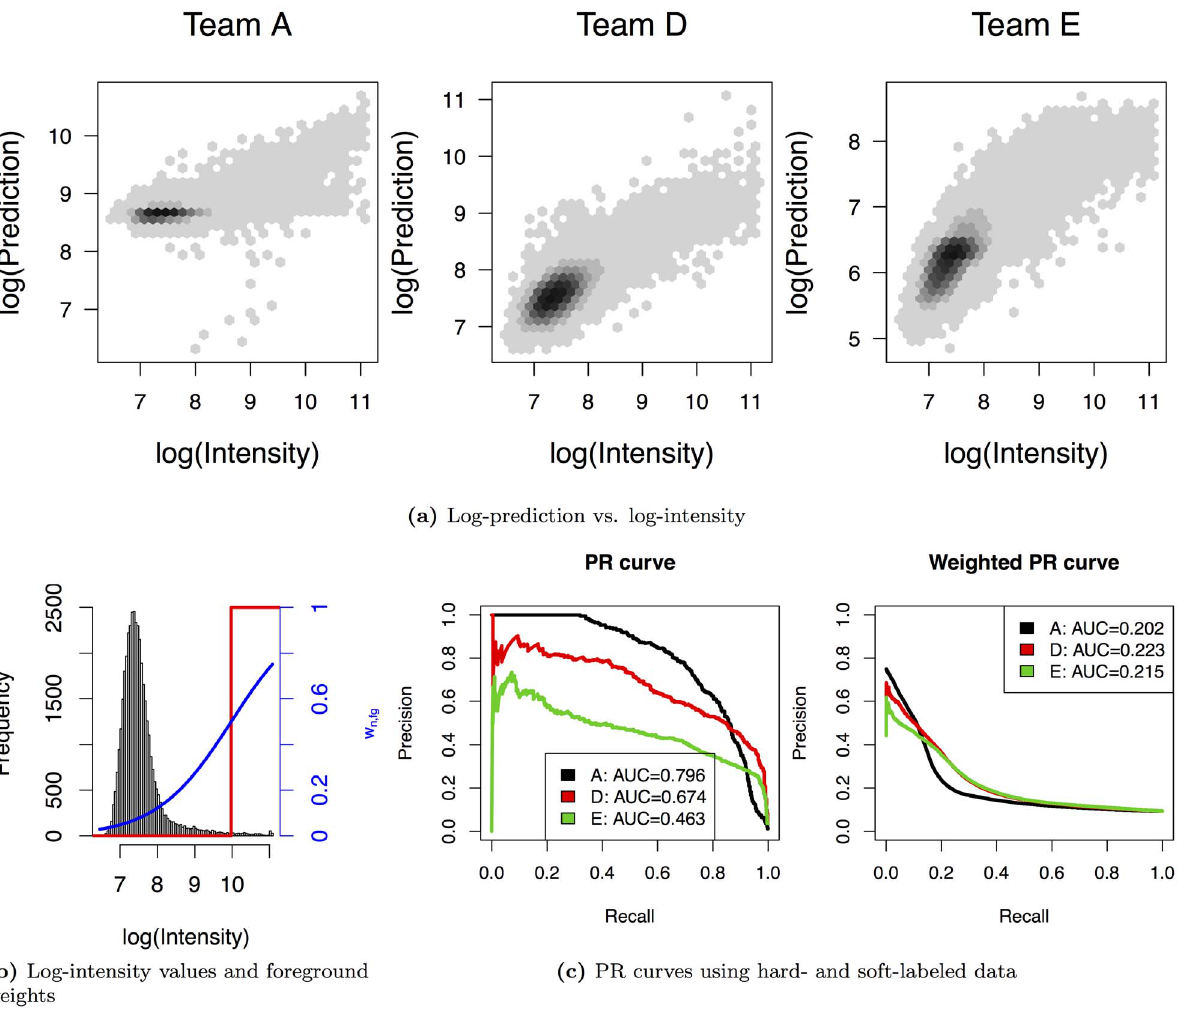
Figure 7. Comparison of PR curves using unweighted and weighted test data for one exemplary data set (11) of [27] . In panel (a), we plot the predicted log-intensity values of classifiers A, D, and E against the measured log-intensity values. Panel (b) visualizes the class border in the unweighted case (red line) and the weights of the foreground class ( w fg , n ) in the weighted case. In panel (c), we show the PR curves of the three classifiers using unweighted (left) and weighted (right) test data.